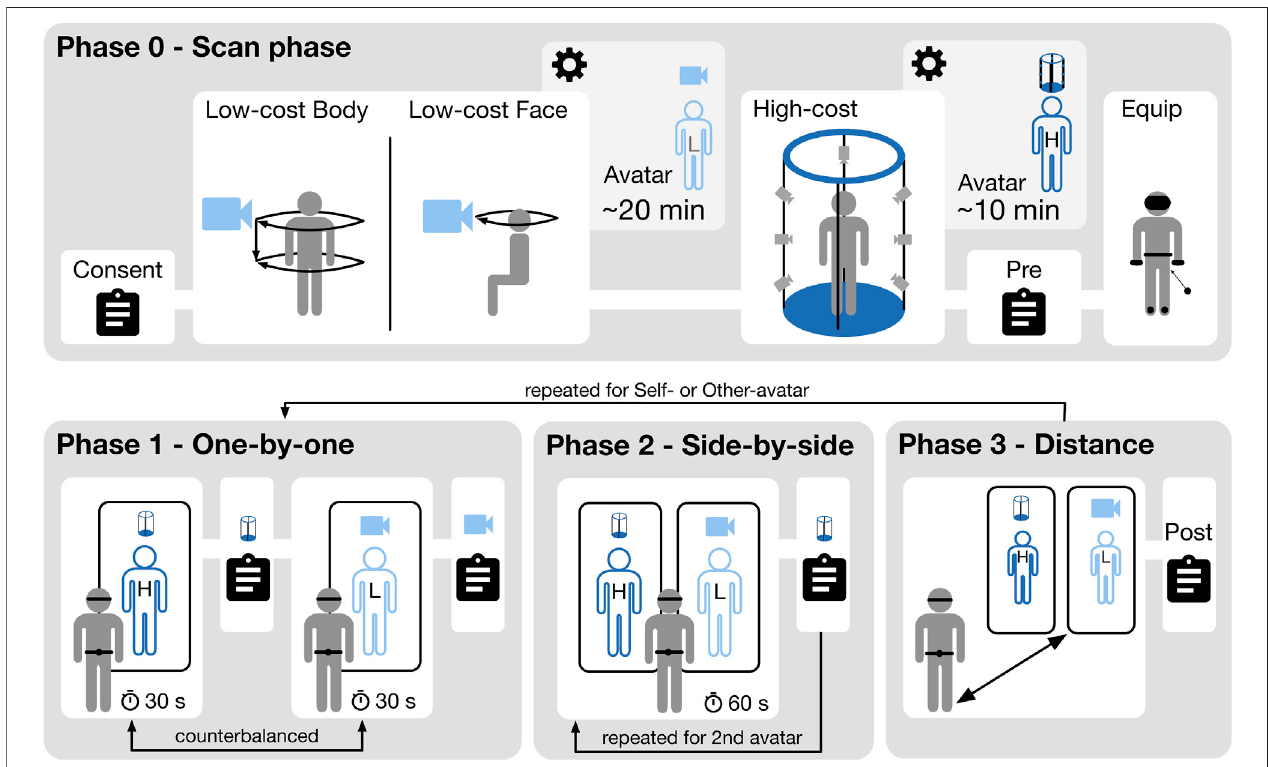
FIGURE 4 | The experiment procedure. Phase 0 includes the low- and high-cost scan and avatar creation. Phases 1 to 3 describe the VR exposure. The embodiment in phases 1 and 2 always matched the virtual human to be rated. In Phase 3, participants were embodied with the avatar version they had rated last.